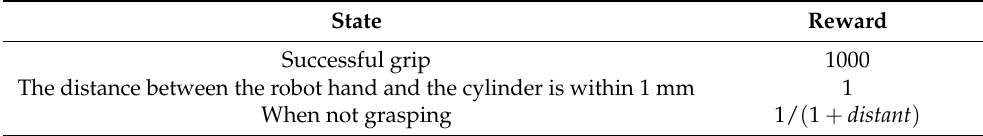
Table 5. Reward setting. State Reward Successful grip